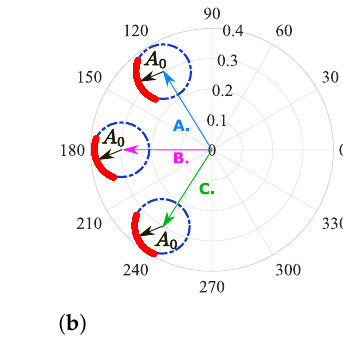
Figure 5. Illustration of the effect of a non-static scenario in the complex plane: ( a ) Reflection schematics on the monitoring environment, ( b ) Equivalent projection of the received signal on the complex